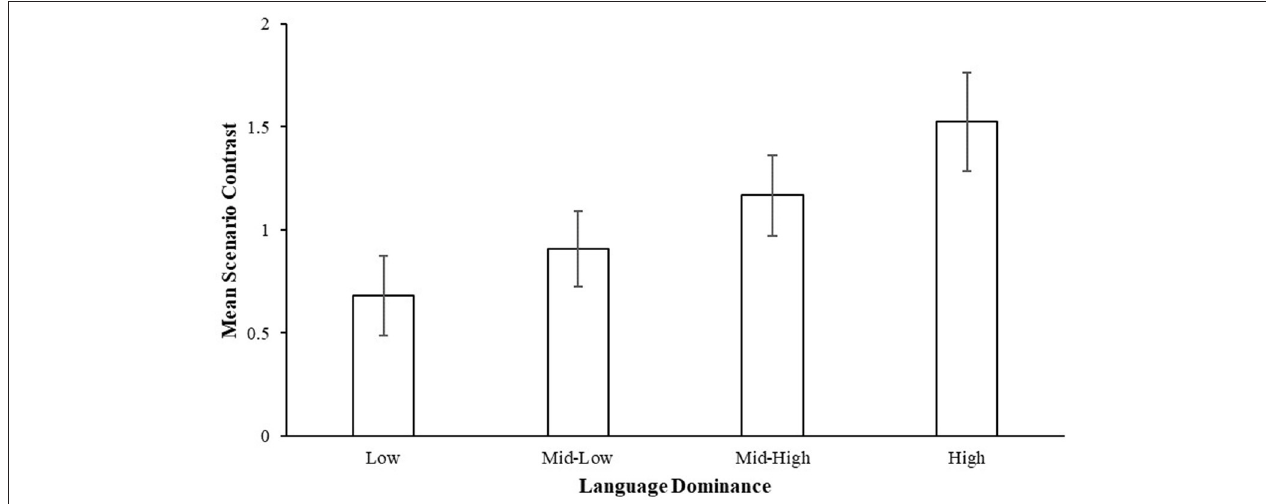
FIGURE 4 | Mean scenario contrast scores by language dominance groups. A higher score indicates a larger average difference in utilitarian ratings between an impersonal minus personal choice of action in the same scenario type. Error bars represent standard errors of the group means.